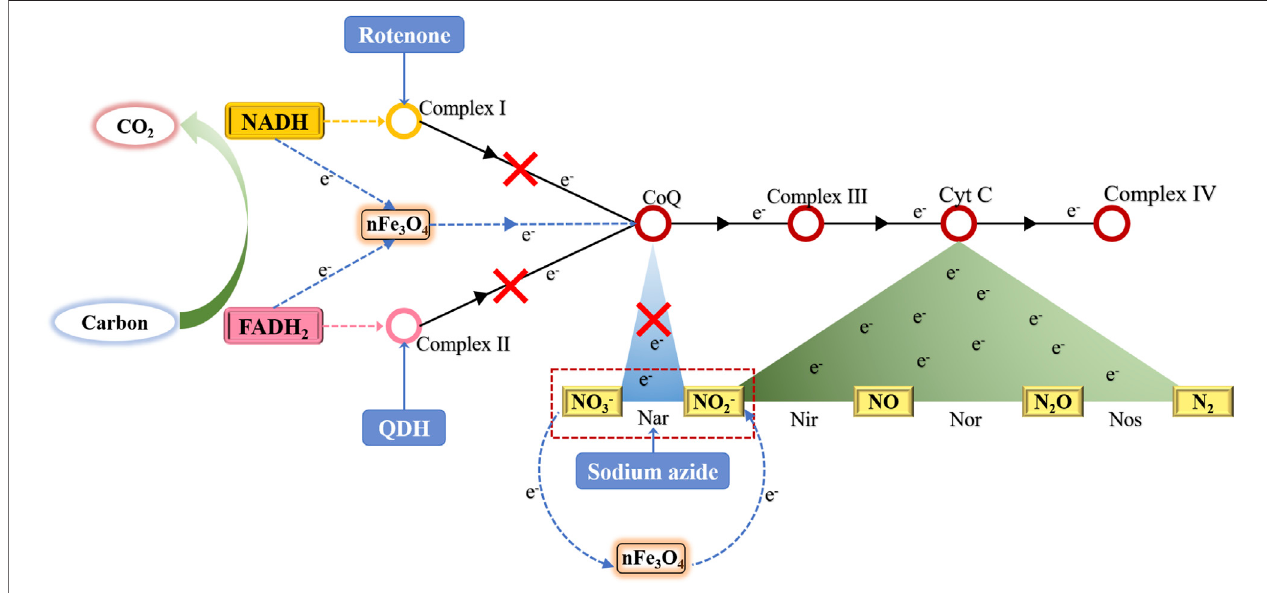
FIGURE 10 | Electron transfer chain in denitri fi cation and the possible role of electron transfer of MAS-nFe 3 O 4 in the system.